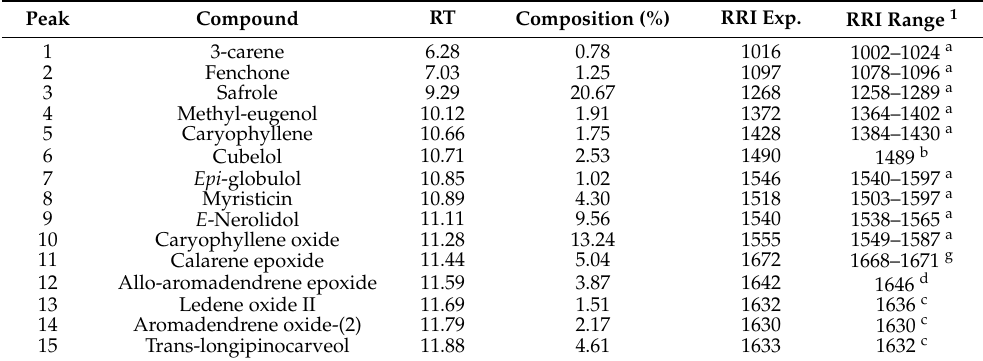
Table 1. Chemical composition of essential oil of Piper cordoncillo var. apazoteanum